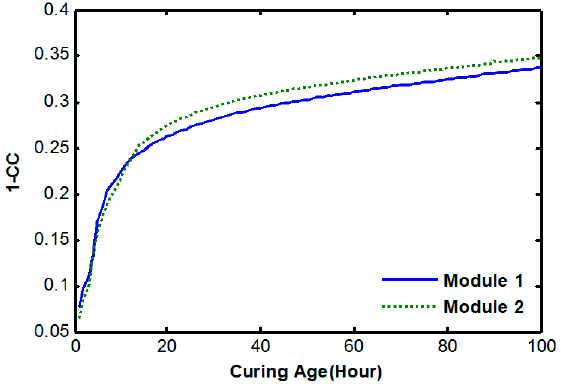
Figure 8. Cross correlation variations during the early-age of the curing stage.